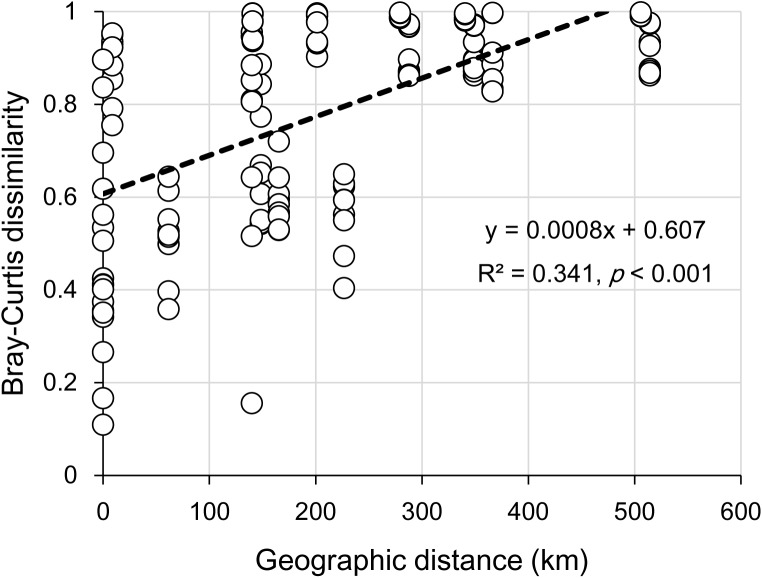
Linear relationship between geographic distance and the Bray-Curtis dissimilarities of the benthic algal communities among the studied lake samples.